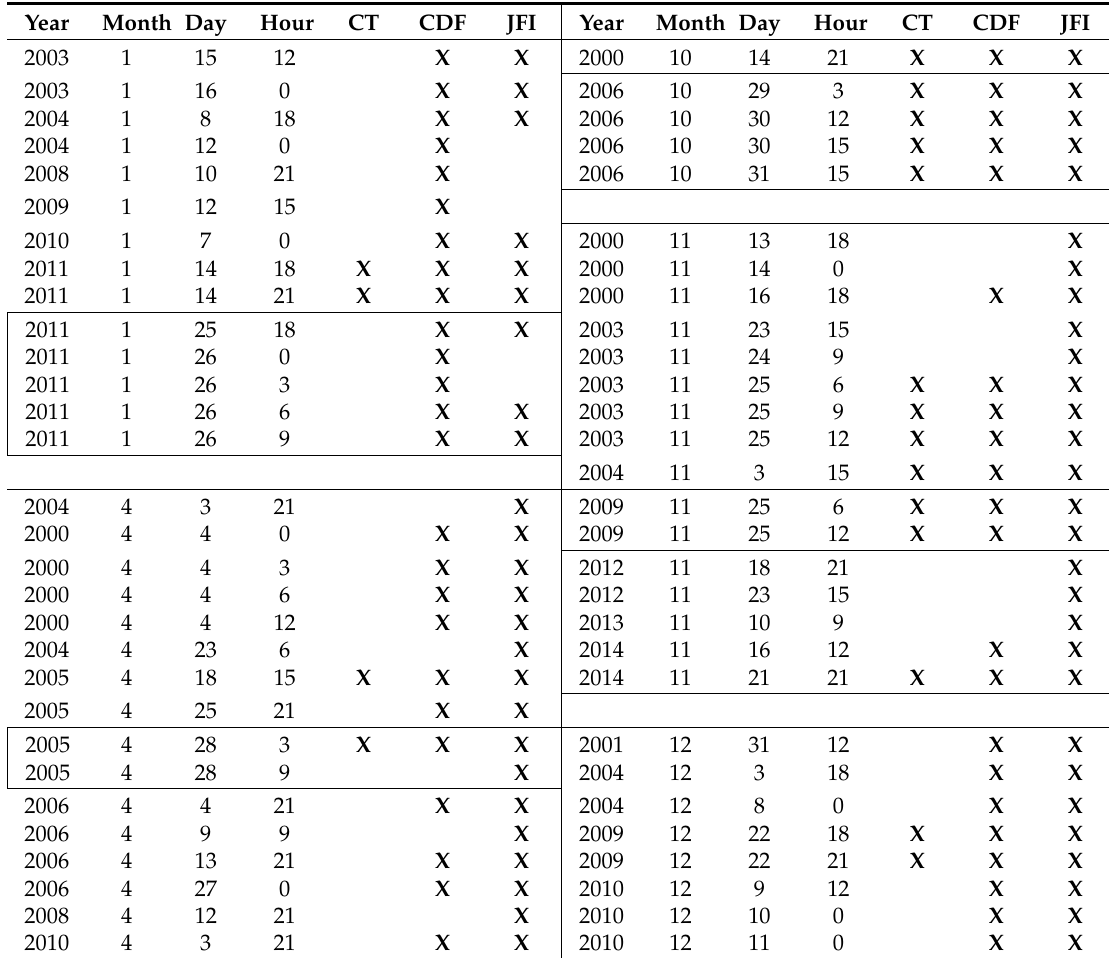
Table 4. Estimated flood dates and time (UTC) according to the constant threshold (10.37 mm/h), cumulative distribution function (90%) and Jeddah flood index